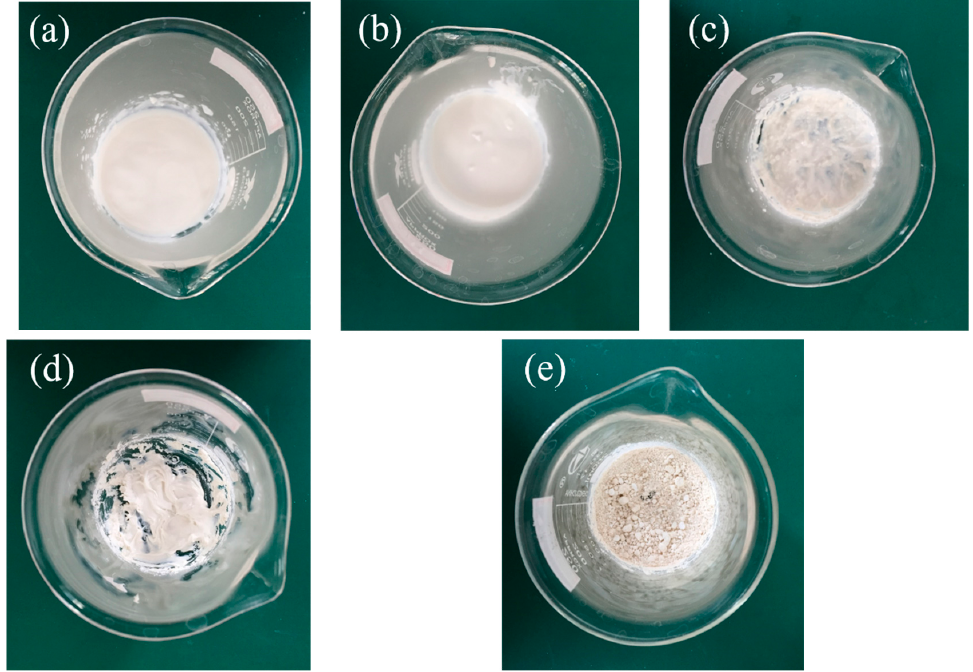
Figure 1. The preparation picture of Palmitic Acid (PA)/mullite composites ( a ) S-1-2; ( b ) S-1-3; ( c ) S-1-4; ( d ) S-1-5; ( e ) S-1-6.